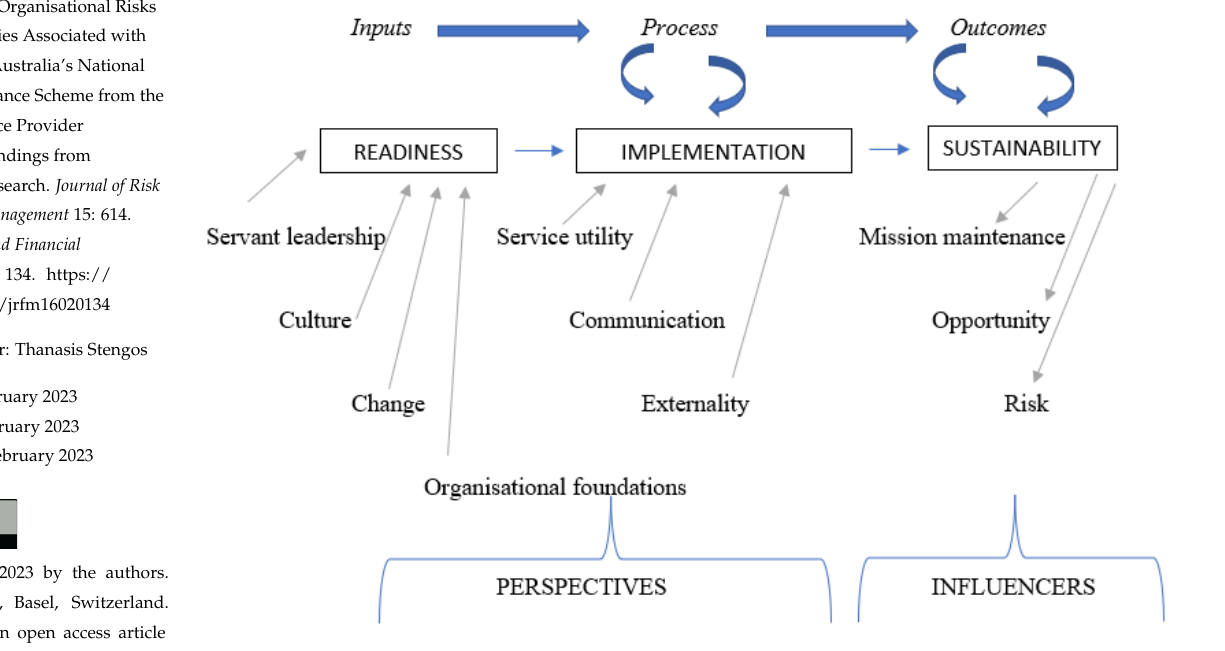
Figure 1. The NDISIF (implementation framework) (Rosenbaum and More 2022, p. 427). The authors apologize for any inconvenience caused and state that the scientific con- clusions are unaffected. This correction was approved by the Academic Editor. The origi- nal publication has also been updated.